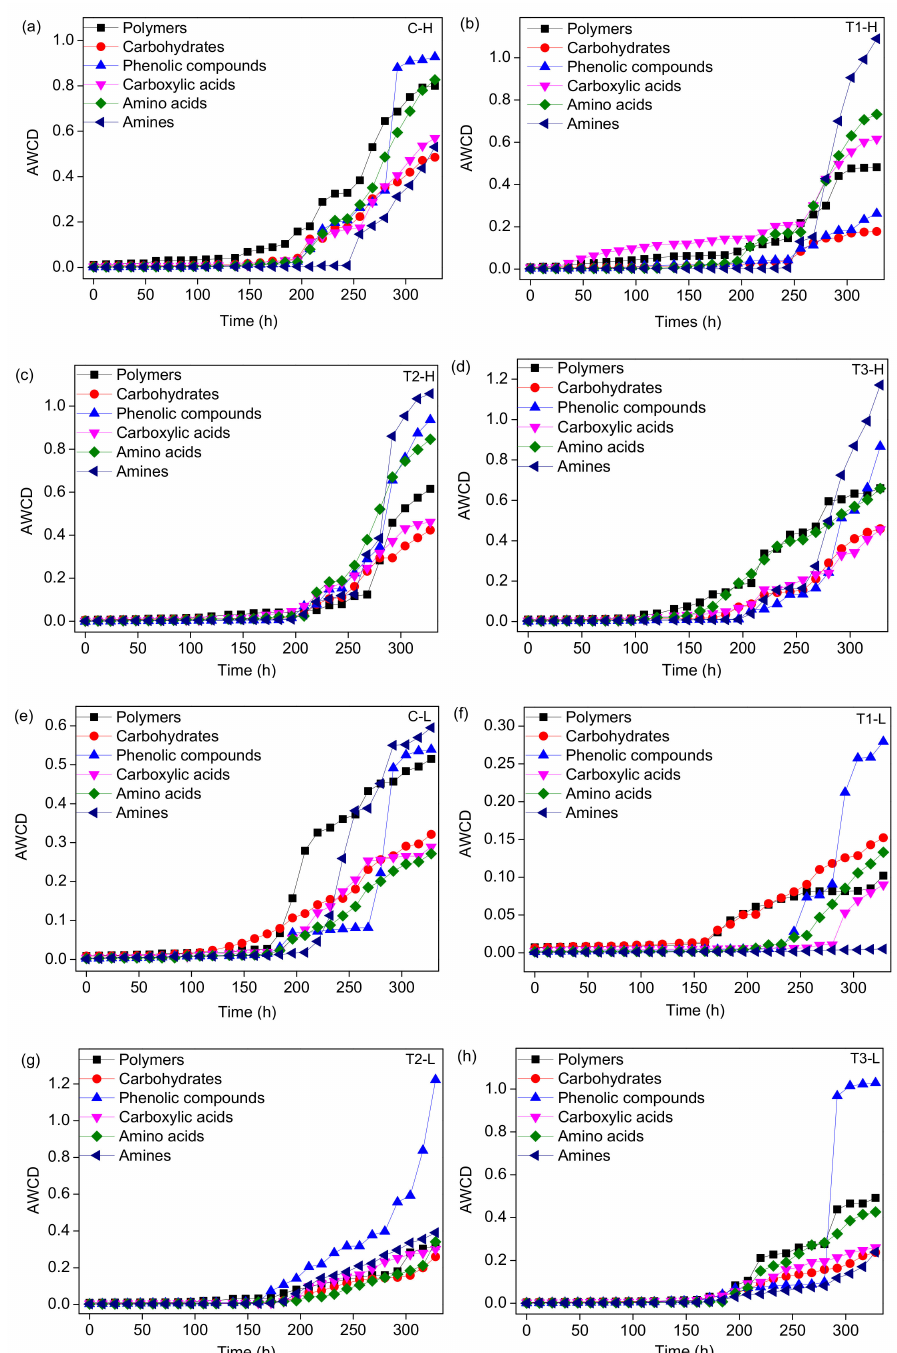
Figure 7. Metabolic response of micro-organisms to six carbon sources in di ff erent treatment groups. C-H group ( a ), T1-H group ( b ), T2-H group ( c ), T3-H group ( d ), C-L group ( e ), T1-L group ( f ), T2-L group ( g ), and T3-L group ( h ). The samples numbers are shown in Figure